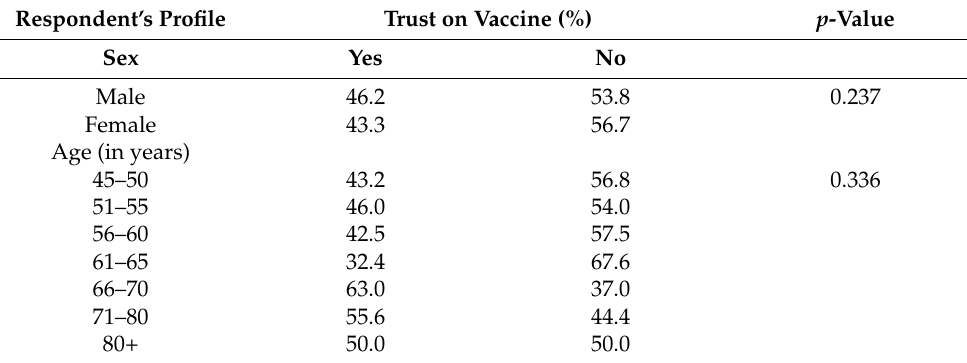
Table 6. Percentage distribution of Age and Sex with trust over